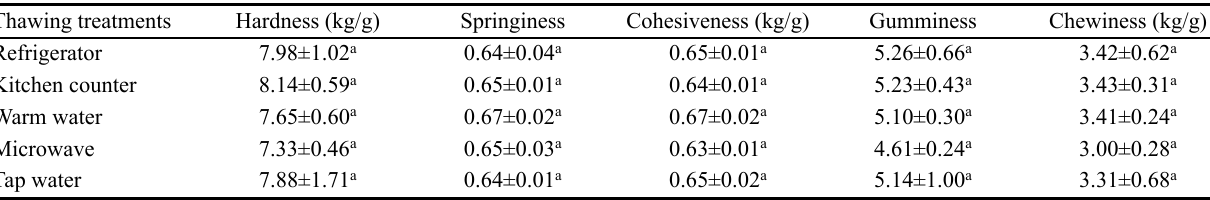
Table 7. Texture profile analysis of chicken breast the samples after defrosting using home based thawing practices and cooking Thawing